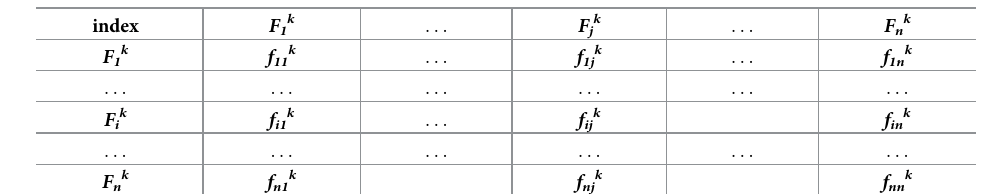
Table 2. General form of the judgment matrix.